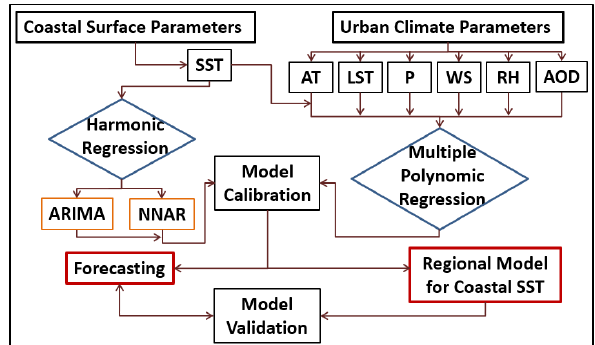
Figure 2 . Methodology flow